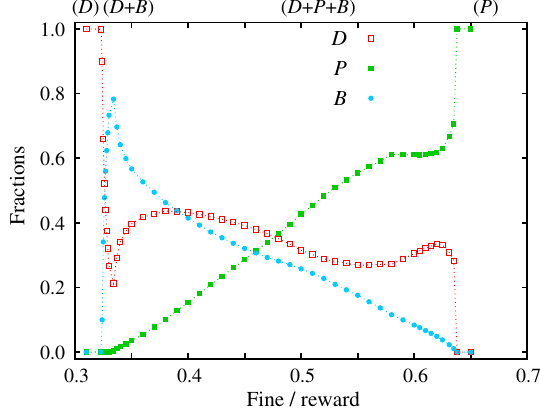
FIG. 9. Cross section of the phase diagram depicted in Fig. 5, as obtained for (cid:2) ¼ 0 : 05 . Depicted are stationary fractions of the four competing strategies in dependence on (cid:1) . Stable solutions are denoted along the top axis. In this cross section, the pure D phase first gives way to a very narrow interval where the two-strategy D þ B phase precedes the spontaneous emergence of cyclic dominance between strategies D , P , and B . The last (from left to right) D þ P þ B ! P phase transition is qualita- tively similar to the D þ P þ B ! D ð B Þ phase transition de- picted in Fig. 6, only here it is the fraction of strategy B that decays to zero as (cid:1) increases, and which thus interrupts the closed cycle of dominance. (In Fig. 6, it is the fraction of strategy P as (cid:2) increases that has the same effect.)